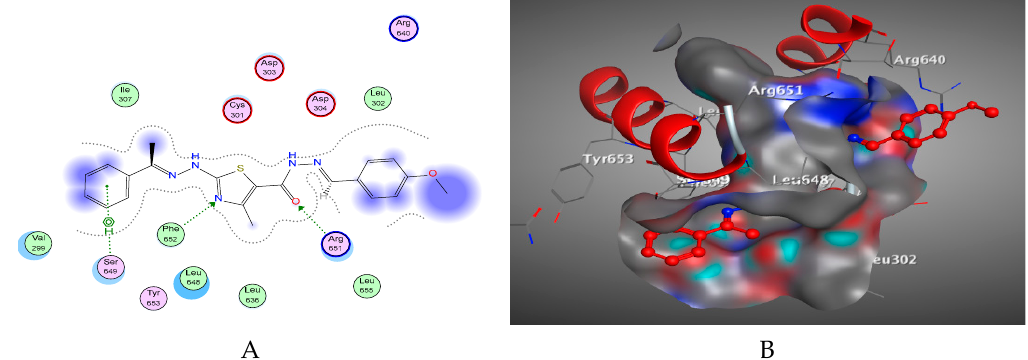
Figure 2. ( A ) 2D pose and ( B ) surface map of the interaction of 1 into the active sites of SARS-CoV- 2 RdRp (PDB: 7bv2).